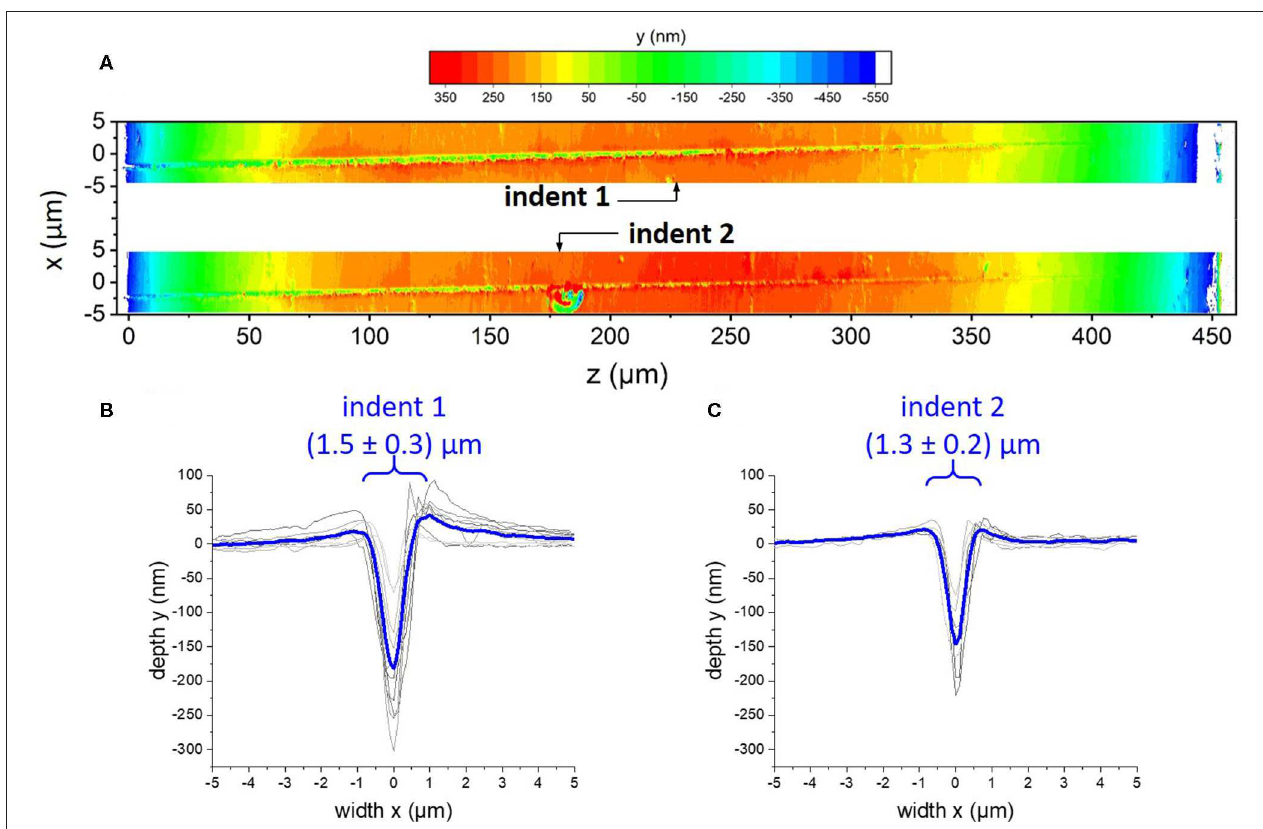
FIGURE 1 | (A) Wide-field confocal microscopic images showing the topography of the residual wedge imprints on vitreous silica after unloading. The coordinate system is adapted from the beamline experimental set-up, displaying the height variances in y -direction with the color code shown in the top. (B,C) show cross-profiles in x -direction at different positions z along the imprint (gray curves) and their average (blue curve) for indent 1 in (B) and indent 2 in (C)